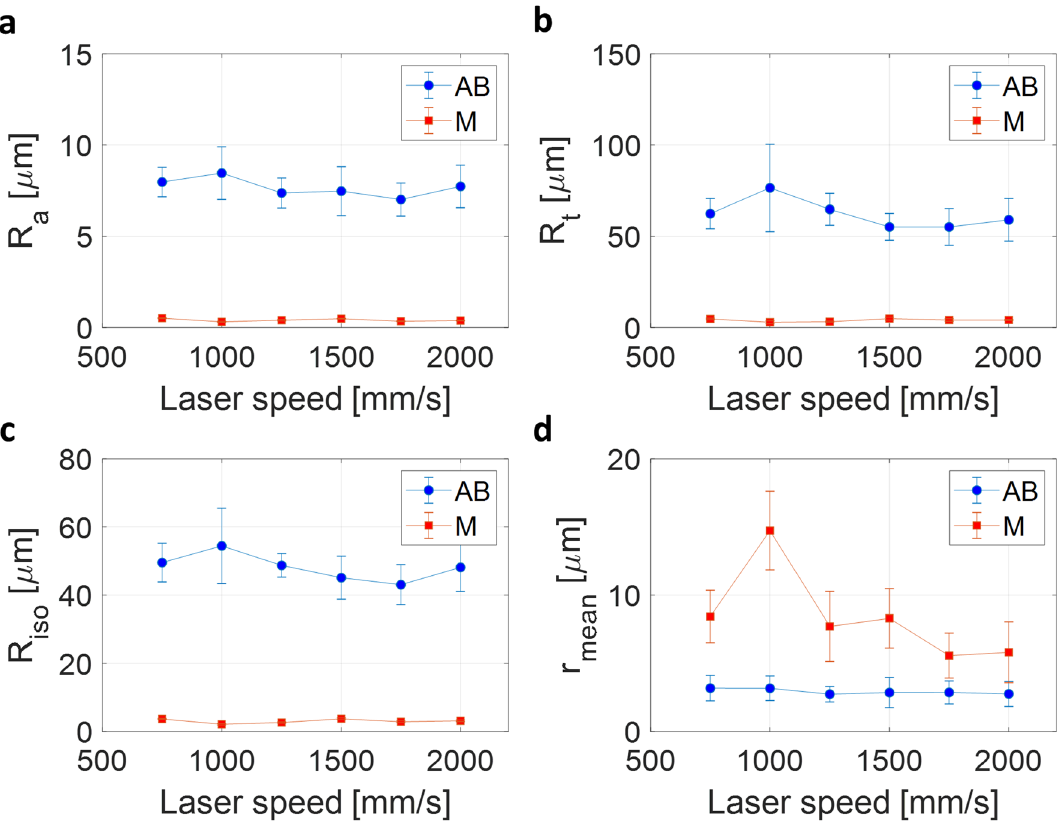
Figure 8. Surface roughness of blasted (AB) and machined (M) samples. Each data point is calculated from 20 different line profiles, and each error bar indicates the standard deviation for the 20 measurements. (a) Average roughness as a function of the laser speed. (b) The maximum peak-to-valley roughness. (c) 10-point height roughness. (d) Estimated average radius of the curvatures at the lowest